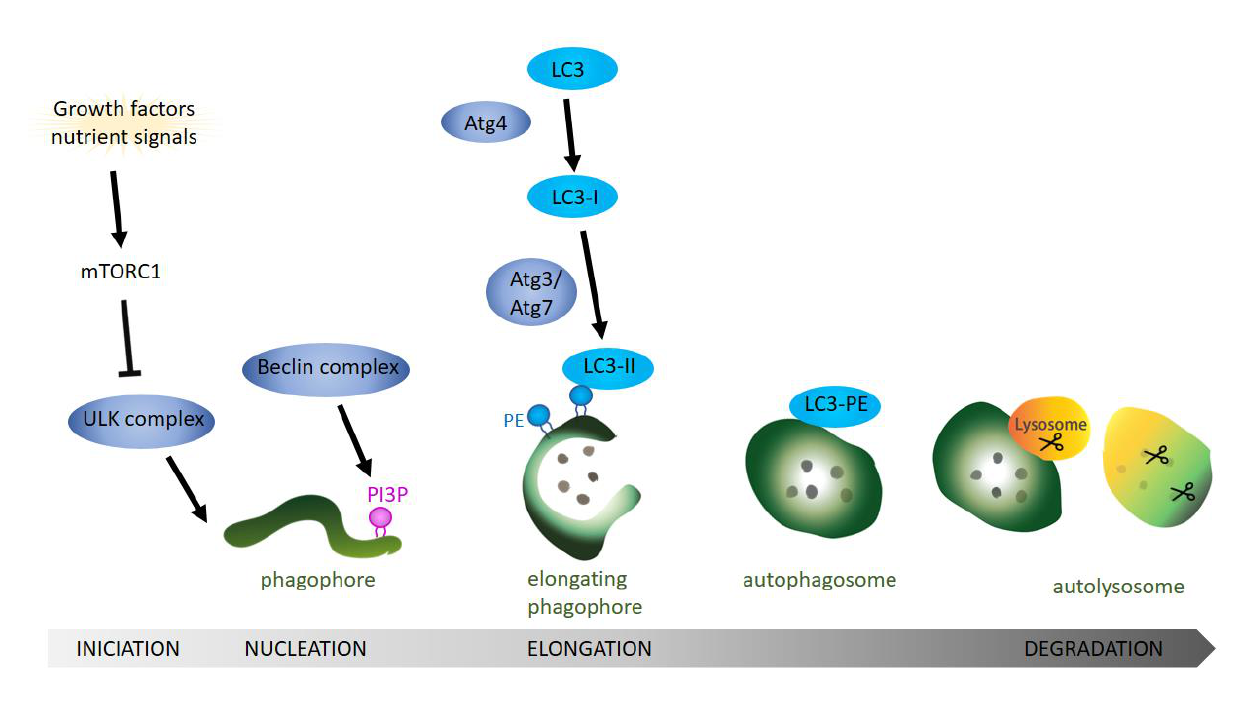
FIGURE 1: General overview of the autophagy pathway. Schematic drawing showing the autophagy process starting with the formation of the phagophore, followed by the completion of the autophagosome and finishing with the fusion of the autophagosome with the lysosome. Growth factors and nutrient signals inactivate the mammalian target of rapamycin complex 1 (mTOR1) leading to the activation and recruitment of the ULK complex to the phagophore. Activity of the Beclin complex leads to local enrichment of phosphatidylinositol-3-phosphate (PI3P). During the elongation of the phagophore, ATG4 processing of LC3 (ATG8 in Drosophila) and the subsequent conjugation to phosphatidylethanolamine (PE) on the phagophore membrane via ATG3 and ATG7 is essential step to form the autophagosome. After the fusion of the lysosome with the ma- ture autophagosome, lysosomal proteases like cathepsin D degrade the autophagosomal